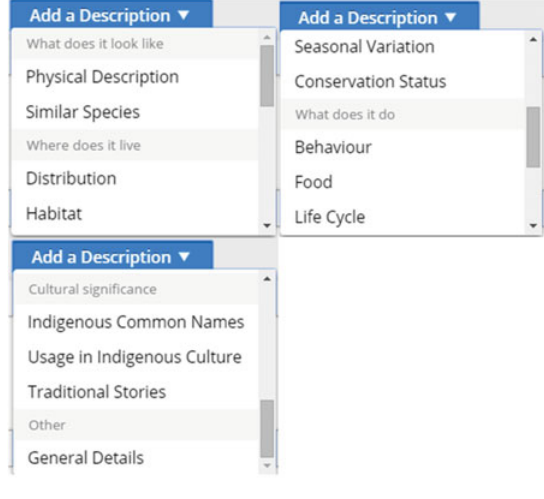
(Colour online) Options of fields into which data can be